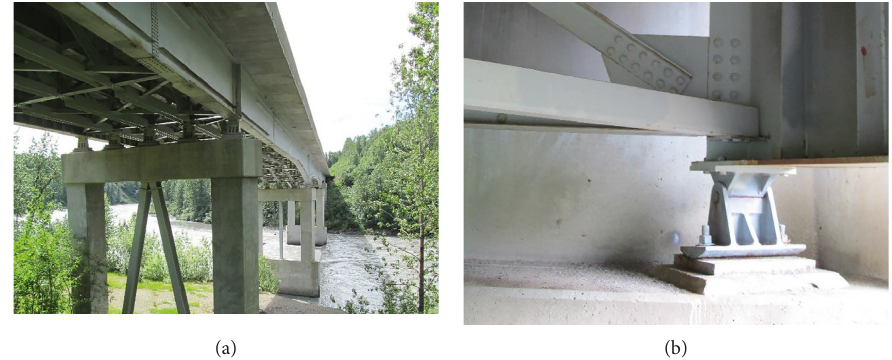
Figure 1: Photographs of the bridge system: (a) Chulitna River Bridge and (b) expansion bearing condition.